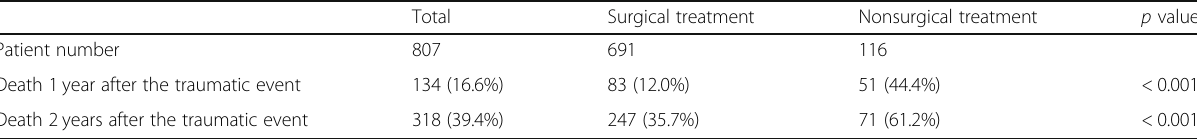
Table 1 Mortality rates of surgical and nonsurgical treatments Total Surgical treatment Nonsurgical treatment